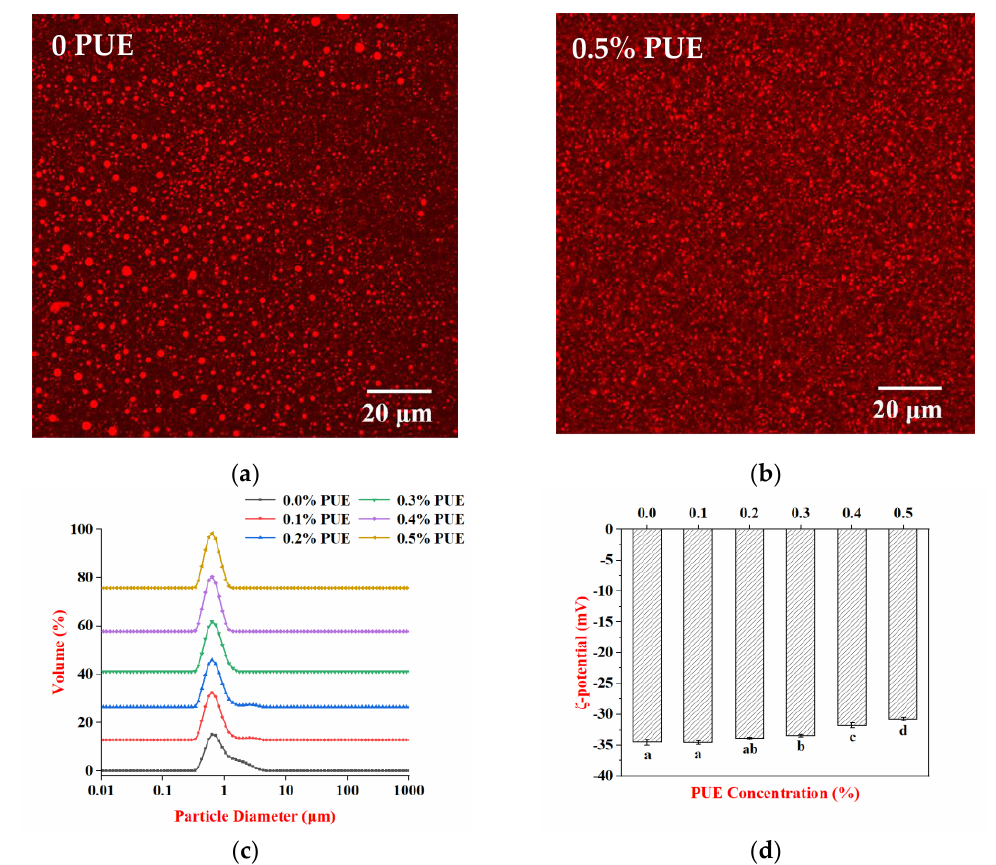
Figure 1. Properties of emulsions stabilized using whey protein isolate (WPI) only (0 puerarin (PUE)) or WPI – PUE composites with different concentrations of PUE (from 0.1% to 0.5%). ( a ) Confocal micrographs of WPI emulsion; ( b ) confocal micrographs of WPI – PUE emulsion with 0.5% PUE, the scale bar corresponds to 20 µm; ( c ) particle size distribution; and ( d ) ζ -potential.